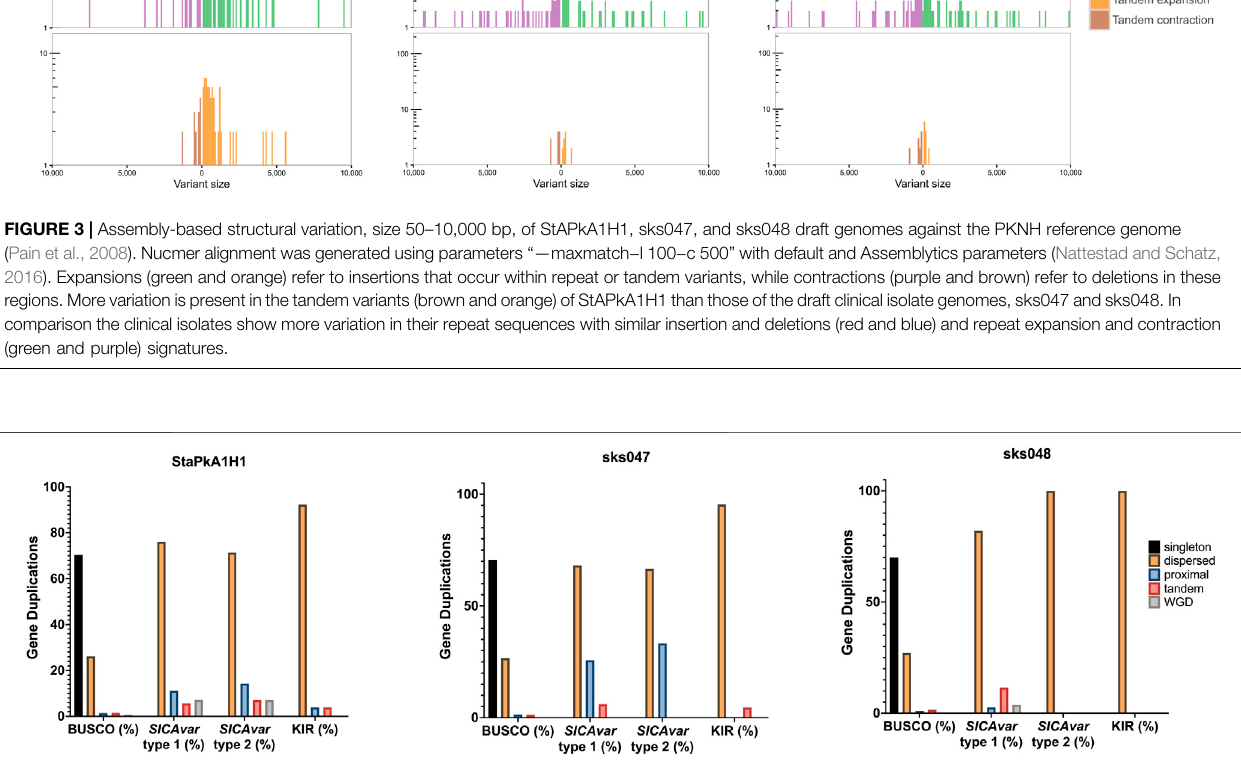
FIGURE 4 | Gene duplication classes for the draft genome assemblies for StAPkA1H1 (experimental cultured line) and the clinical isolates sks047 and sks048. Gene duplication was quanti fi ed and classi fi ed using MCScanX (Wang et al., 2012) for all genes in each genome and identi fi ed as black bars, singleton (no identi fi ed duplication); orange bars, dispersed ( > 20 genes between the 2 candidate genes); blue bars, proximal (two identi fi ed duplicated genes with < 20 genes between them); pink bars, tandem (duplication events next to each other); and green bars, segmental/whole genome duplication (WGD) ( > 4 co-linear genes with < 25 genes between them). The gene pools for each genome were divided into BUSCO (core genome genes) for comparison with the genes making up the SICAvar type 1 or SICAvar type 2 or kir multiple gene families. The draft genomes, StAPkA1H1, sks047, and sks048, had roughly similar pro fi les for BUSCO genes. Singletons (dark blue bars) were absent from the multiple gene families for all of the draft